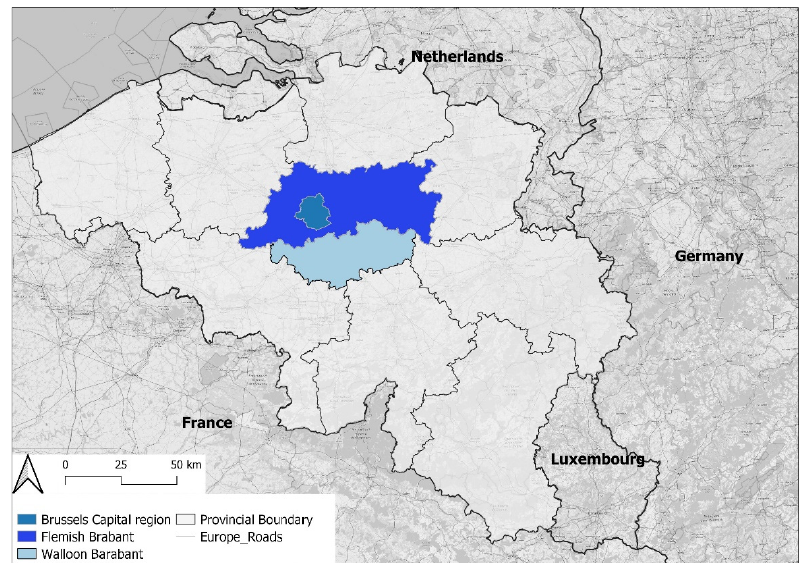
Figure 1. Area of interest showing the Brussels Capital Region, Flemish Brabant and Walloon Brabant.